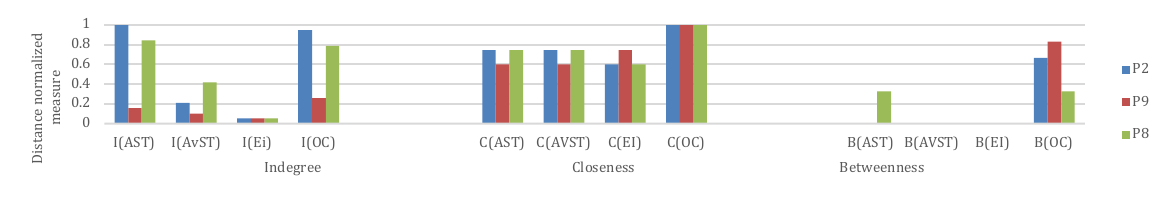
Figure 24d) Distance normalized measure values for AOIs during Turn flight phase .